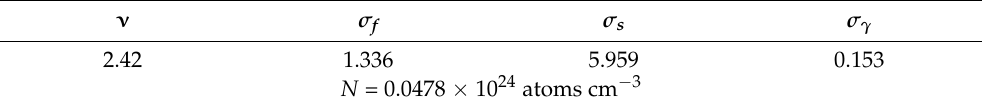
Table 1. One-group bare reactor cross-sections data.